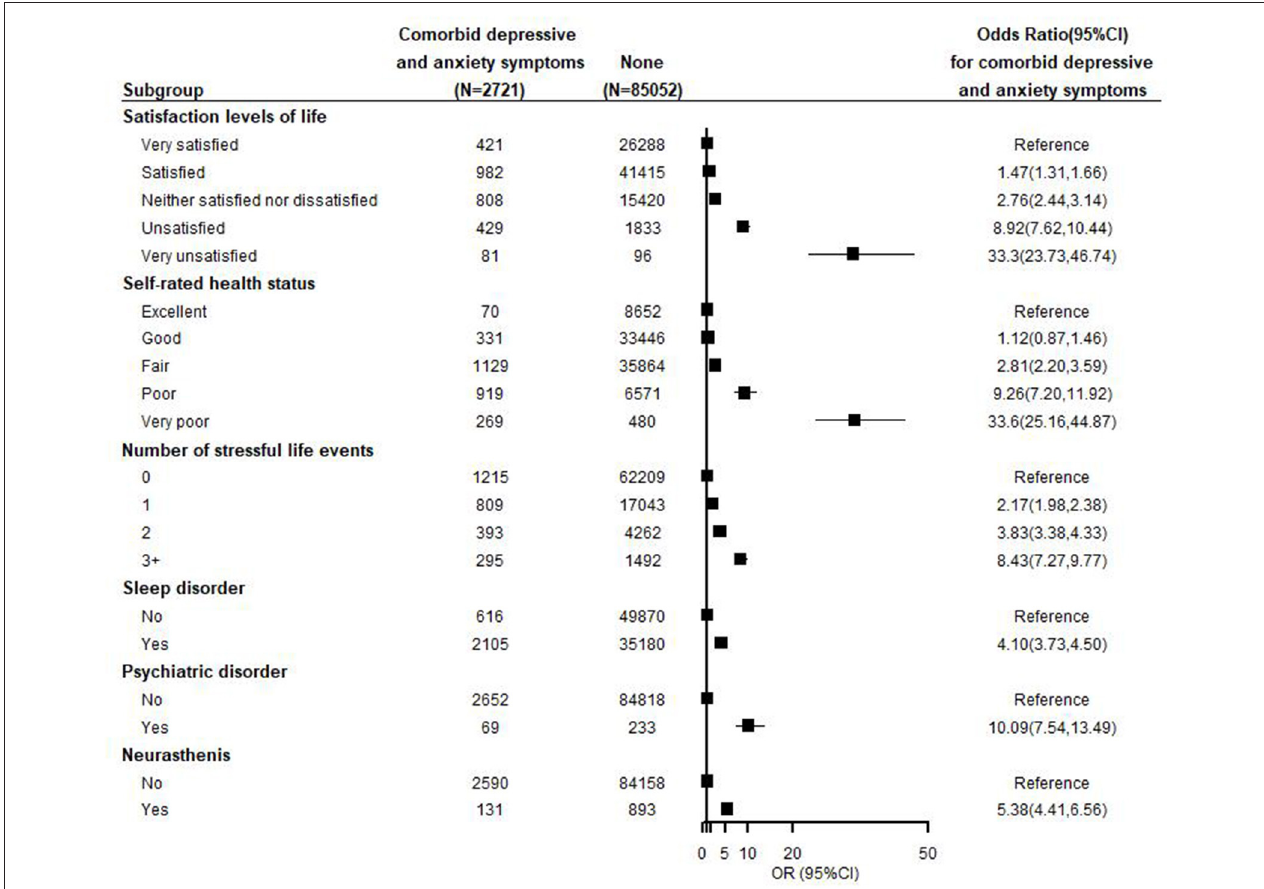
FIGURE 3 | Adjusted odds ratios by health-related conditions and status for comorbid depressive and anxiety symptoms. Each closed square represents an odds ratio, and the horizontal lines represent the 95% confidence interval (CI). All odds ratios were adjusted for age, sex, nationality, marriage, education level, occupation, income, smoking, alcohol consumption, tea consumption, BMI, physical activity, and